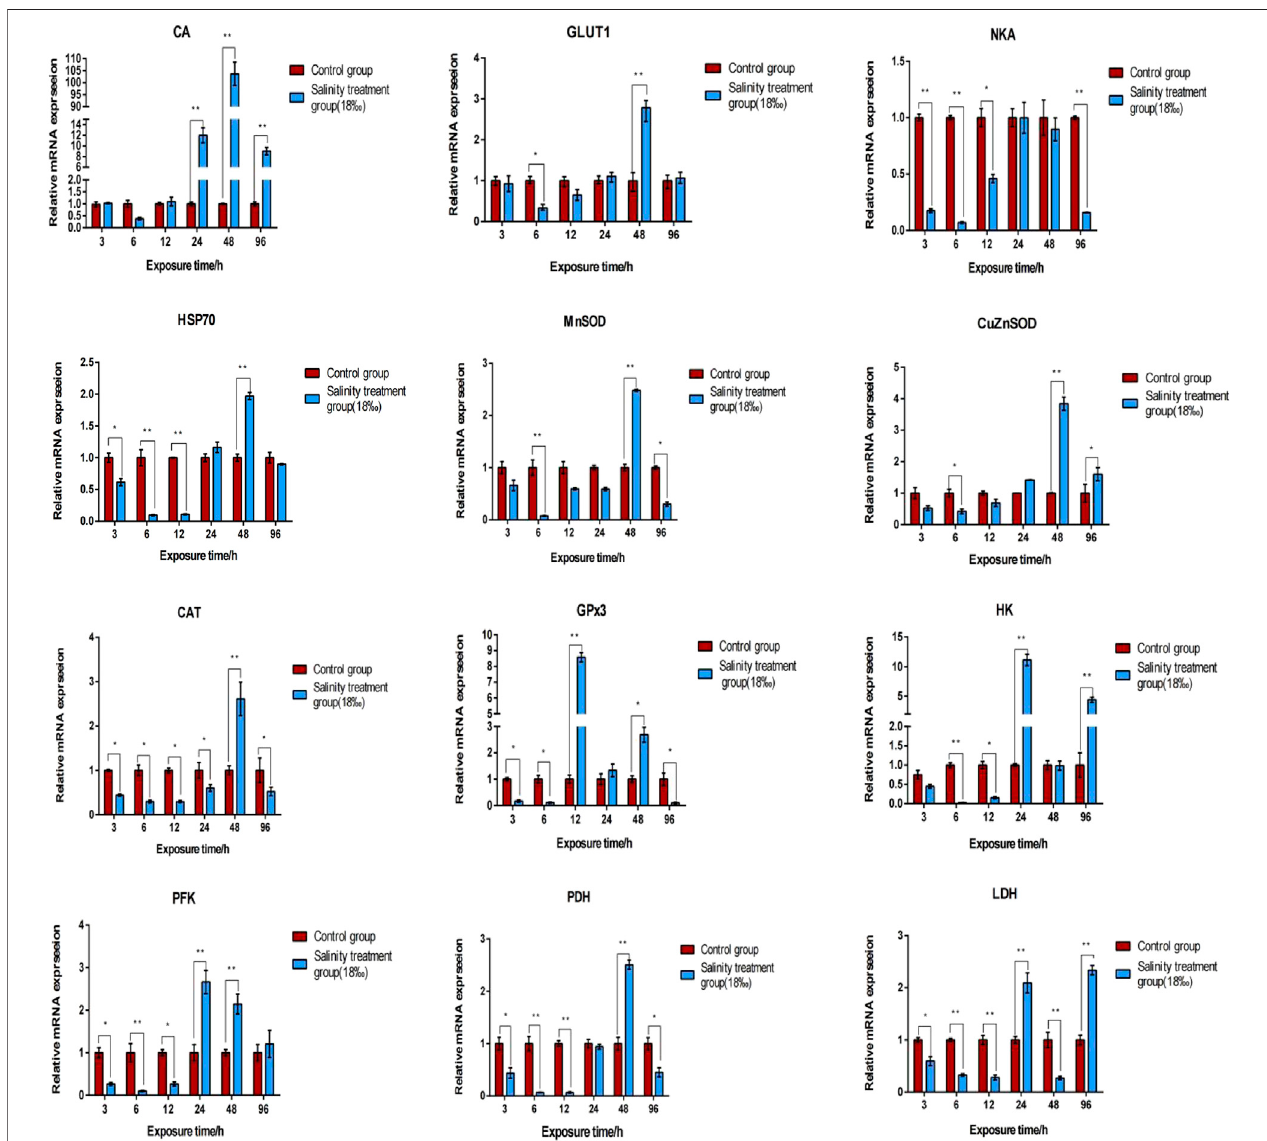
FIGURE4| Validationoftheexpressionpro fi lesof12DEGsidenti fi edinthegilltissueof M.nipponense usingqPCR.Log-foldchangesareexpressedastheratioof gene expression after normalization to β -actin expression levels. Data are shown as mean ± SE (standard error) of tissues in three separate individuals. *indicates signi fi cant difference ( p < 0.05), pp indicates extremely signi fi cant difference ( p < 0.01).